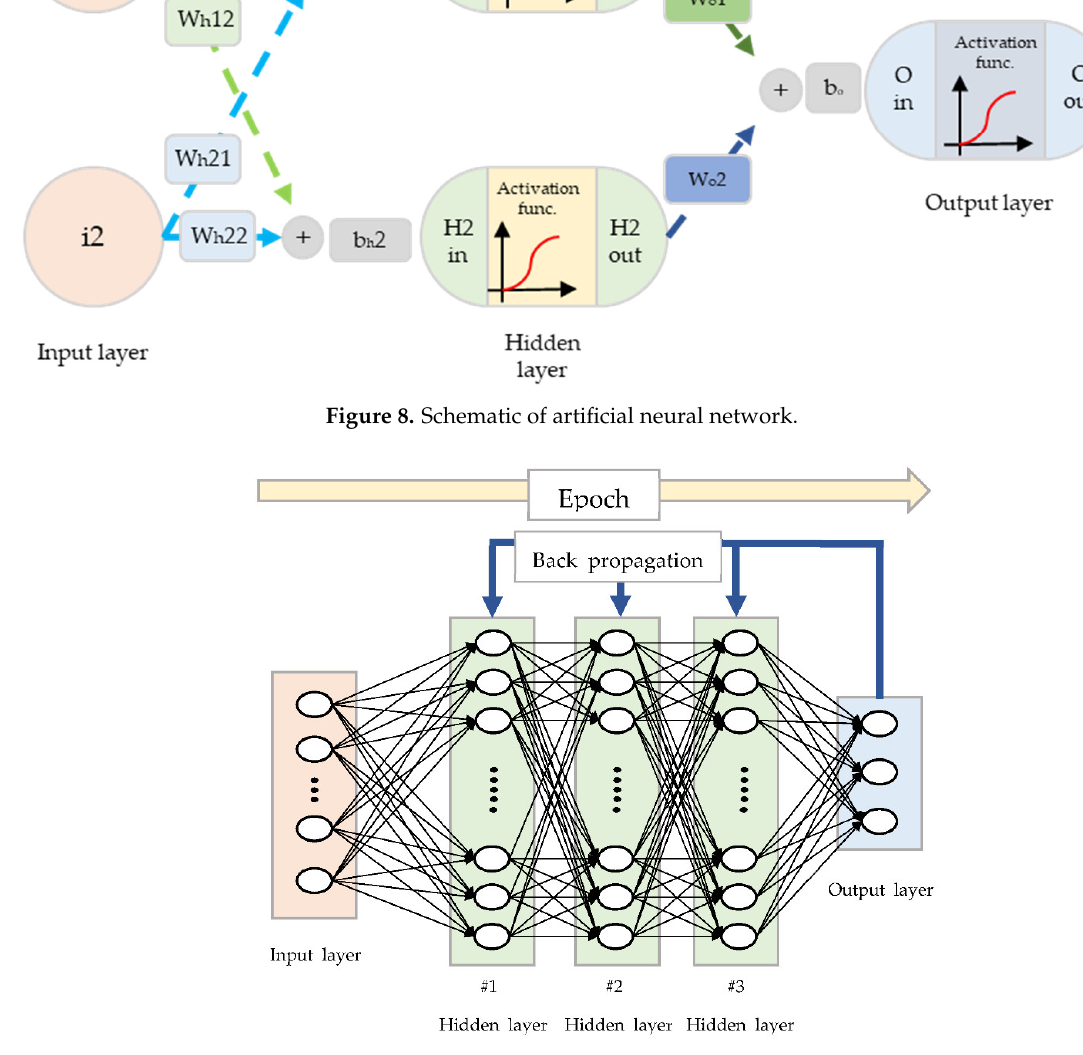
Figure 8. Schematic of artificial neural network.